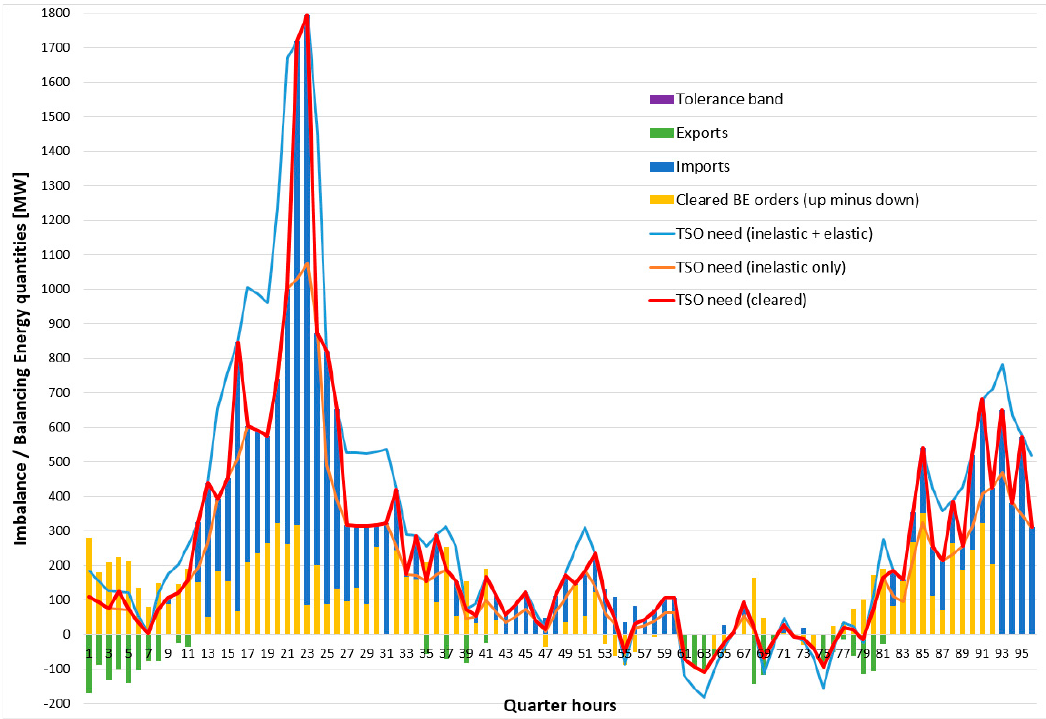
Figure 13. Clearing results per RTU for France.